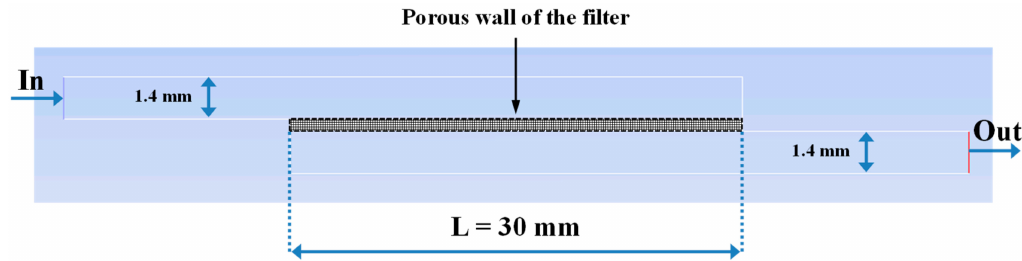
Figure 1. Two-dimensional computational domain (not to scale): single-channel filter (length of the inlet and outlet channels = 45 mm; thickness of the wall = 0.38